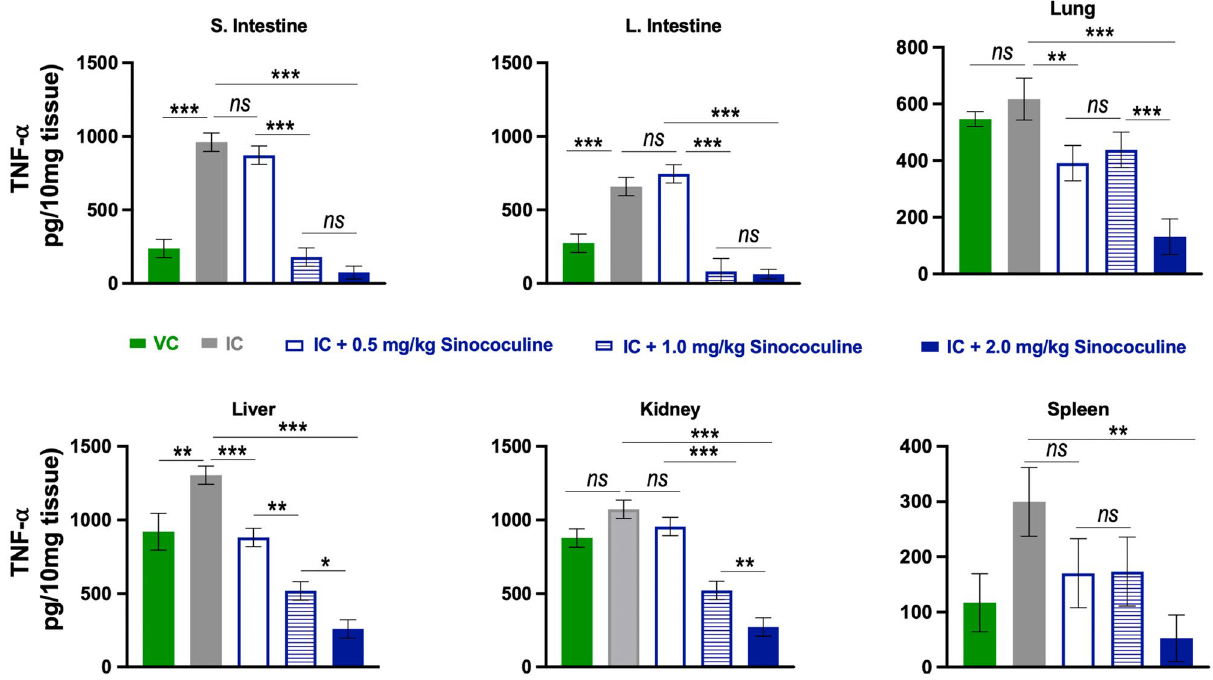
Figure 5. Sinococuline reduces TNF- ⍺ , a proinflammatory cytokine, in several organs of severely DENV-infected AG129 mice. The IC inoculated AG129 mice (n = 3) were treated with Sinococuline doses corresponding to each of the experimental groups described in Fig. 4. In parallel the mice were euthanised on day 4 post-infection, perfused and different organs were harvested for the estimation of TNF- ⍺ using mouse TNF- ⍺ ELISA kit. The TNF- ⍺ levels in each tissue were calculated in pg/10 mg of tissue and graph were plotted by using GraphPad prism. The only Sinococuline (2.0 mg/kg/day) administered group was included and treated similarly to normalise the data across all the panels. The difference of TNF- ⍺ levels between two infected or treated groups were analysed by using Two-way ANOVA with Bonferroni’s multiple comparison test; p ≤ 0.05 were considered as significant (*/**) and p values ≤ 0.001 were considered as very significant